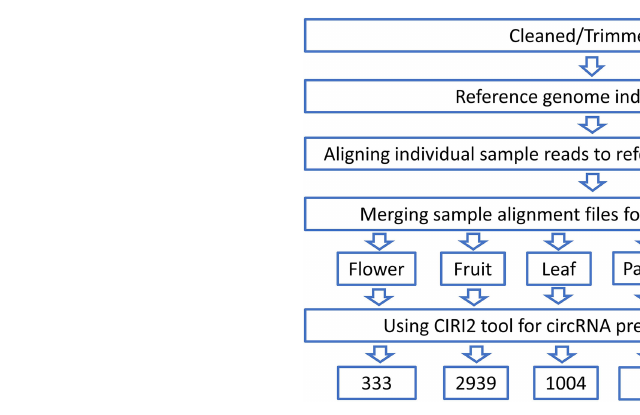
FIGURE 2 Schematic diagram of circRNA identi fi